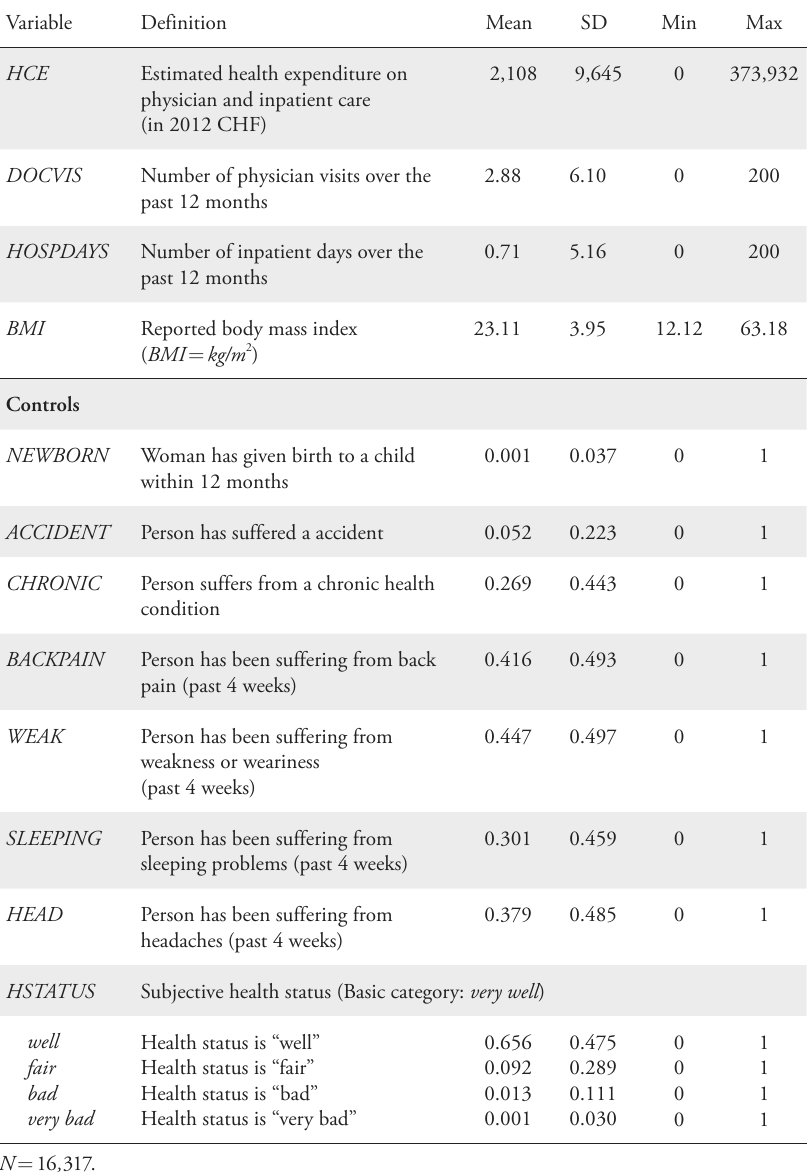
Table 1: Descriptive Statistics of the Main